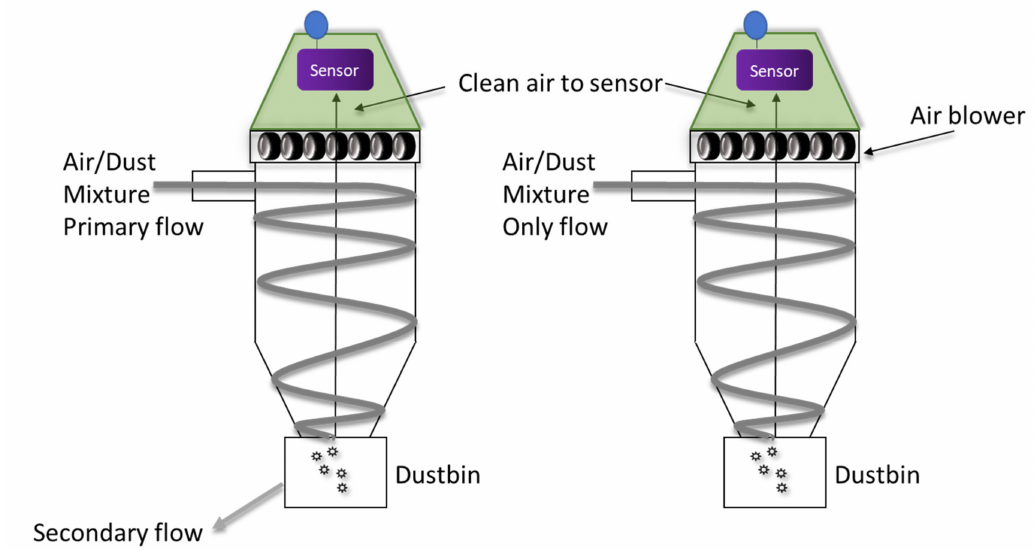
Figure 1. A scheme (not in scale) depicting a cut through the CSR. ( Right )—a conventional CSR with a single air stream. Air is entering the CSR tangentially, forcing the flow into a spiral path. The centrifugal force moves the dust particles toward the wall of the cyclone where they collide and lose their kinetic energy, then finally fall to a dustbin. Air and vapor exit the CSR and enter the gas sensor (not shown). ( Left )—an improved CSR. Improvement is achieved by splitting the airflow between the primary flow (typically 85% of the total flow) and secondary flow. Both schemes show a sensor (purple rectangle) coupled to the exit of the CSR. The sensor samples gases and vapors from the air after the dust has been removed and wirelessly transmits the